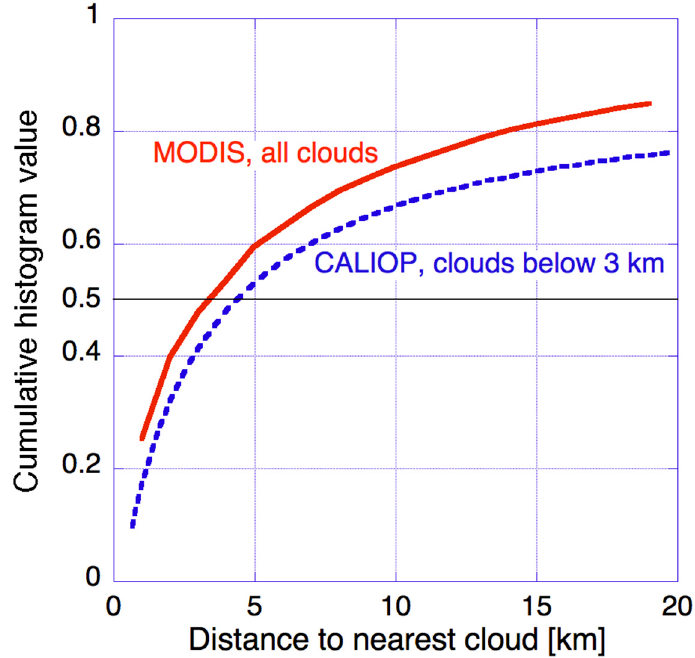
Figure 1. Cumulative histogram of cloud-free atmospheric columns over all oceans, between 60 ◦ N and 60 ◦ S latitudes. The solid curve is for all 1 km size Moderate Resolution Imaging Spectroradiometer (MODIS) pixels with viewing zenith angles less than 20 ◦ from 21 June 2008; the dashed curve is for all 333 m size Cloud-Aerosol Lidar with Orthogonal Polarization (CALIOP) columns observed at night between 15 September 2008 and 14 October 2008. The dashed curve is based on the inset in Figure 1a of [27].